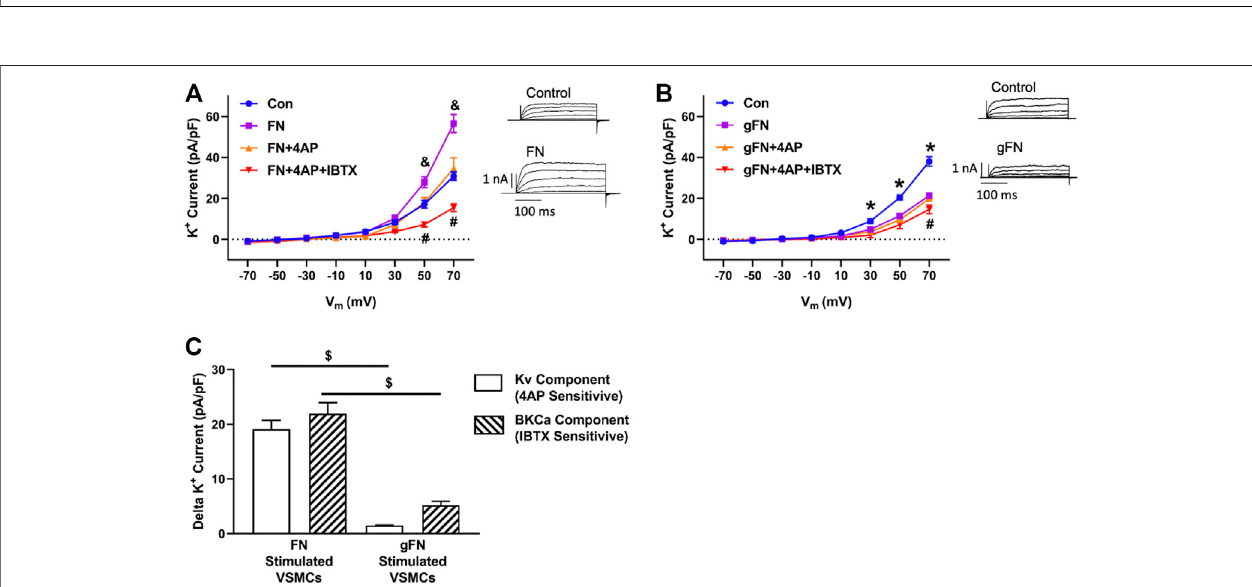
FIGURE 2 | Effects of FN and gFN on major components of whole cell K + current. Panel (A,B) Effect of FN ( n = 12 – 15) and gFN (15 μ g/ml; n = 26), respectively on wholecellK + currentsundercontrolconditionsandinthepresenceofselectiveK + channelinhibitors.ComponentsofthetotalK + currentwereisolatedby4-AP(0.1 mM) to inhibit Kv channels and IBTX (0.1 μ M) to block BK Ca activity. The inserts display representative whole cell K+ currents recorded under control conditions and in the presenceofeitherFNorgFN.& p < 0.05,FNvs.otherconditions* p < 0.05,Controlvs. gFN±channelinhibitors;# p < 0.05,FNorgFN+bothchannelinhibitorsvs. other conditions. Panel (C) illustrates that gFN inhibits the K V and BK Ca channel activities to differing degrees whereas the potentiating effect that fi bronectin exerts on whole cell K + current involves similar contributions from both Kv and BK Ca channels. Total IBTX and 4-AP sensitive currents were obtained from panels (A,B) by calculating the difference between current amplitudes recorded at +70 mV in the presence of either FN or gFN alone vs currents recorded following addition of either 4- AP or IBTX. $ p < 0.05, FN vs. gFN. Bar graphs are presented as mean ± SEM for data at +70 mV.